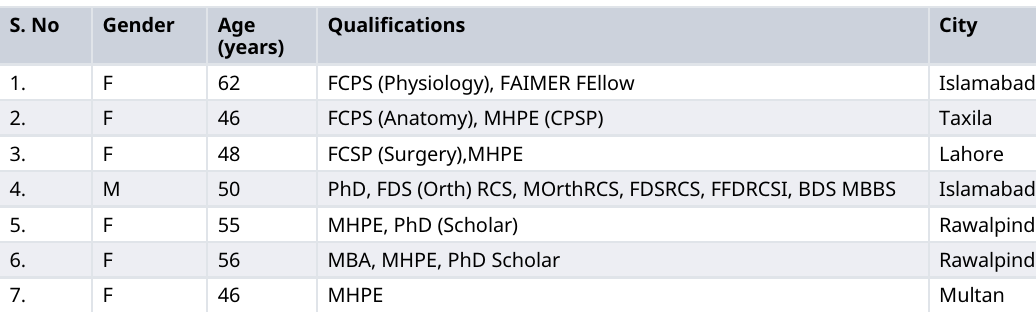
Table 1. Demographic details of the